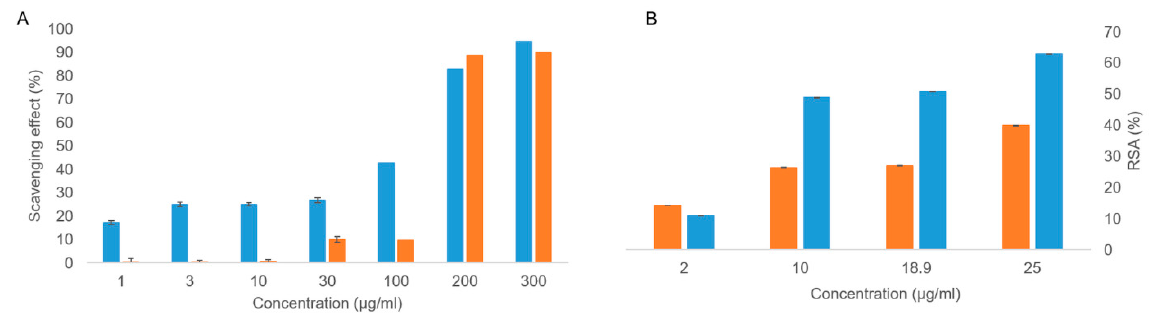
Figure 4. ABTS ( A ) and DPPH ( B ) results of antioxidant activity relevant to OFE (blue bars) and hydroxytyrosol (orange bars).